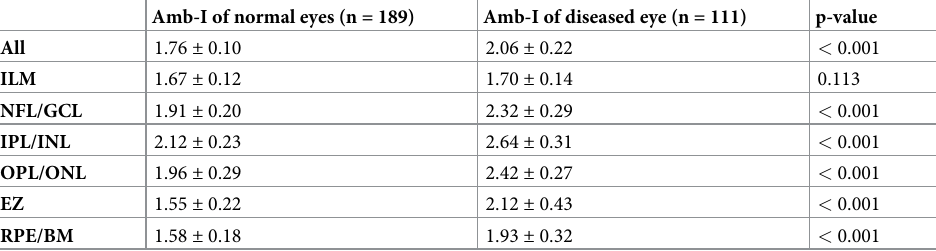
Table 1. Ambiguity index of each layer in normal and diseased eyes.